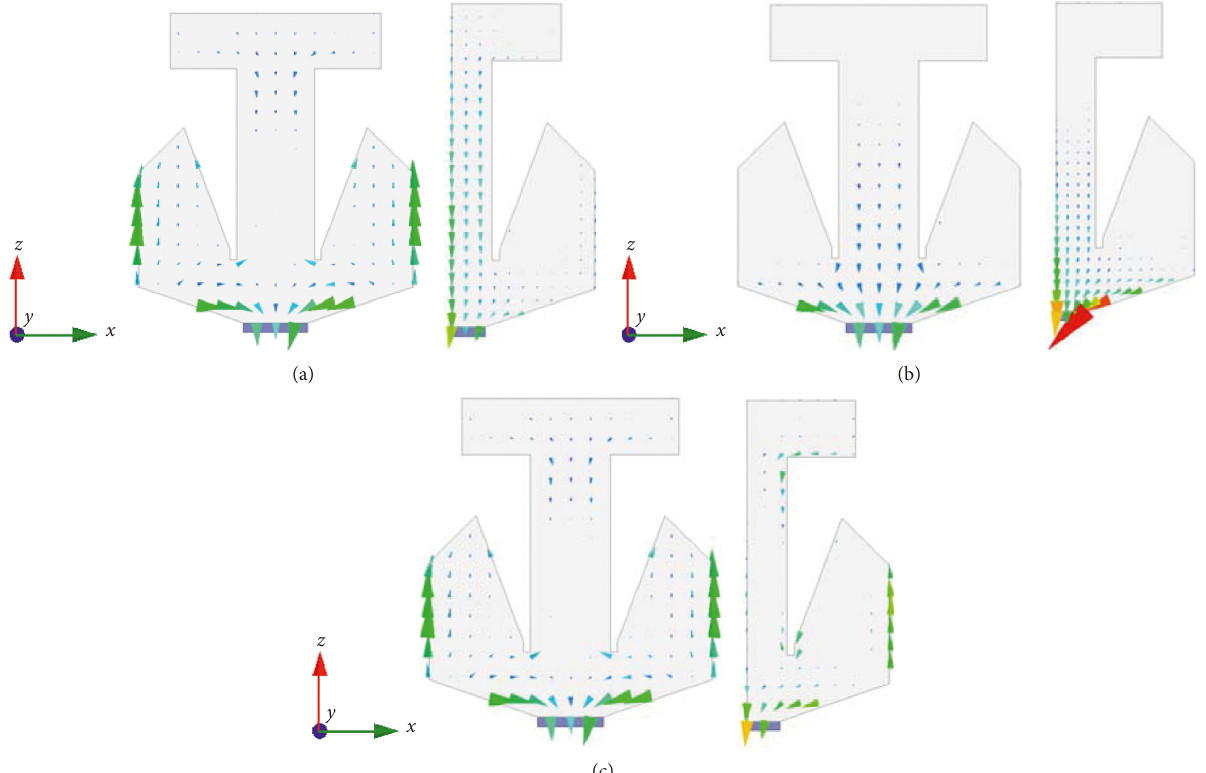
Figure 6: Effect of halving on the surface current distribution of the antenna at different frequencies. (a) 0.9GHz, (b) 2GHz, and (c) trend compared with the simulated E-plane radiation pat- reflection of floor, the main radiation direction of the an- tern, but the main radiation direction is more inclined to 90 tenna is no longer strictly 90 degrees. It is at 45 degrees. At degrees. At 3.5 GHz, the E-plane radiation pattern has 2.5 GHz, the measured pattern also has an upward tilting